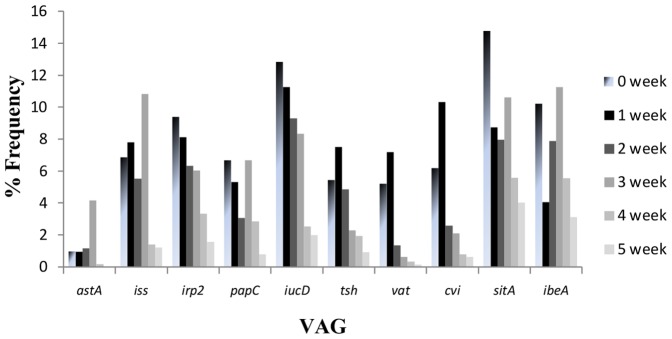
Average percentage frequency of VAGs.(inclusive of all flocks). Average percentage frequencies of 10 VAGs were calculated and plotted against time, from t = 0 (arrival) to t  =  week 5 (depopulation). Overall, VAGs appear to decline with time, with a peak in detection at week 3 for iss, sitA and ibeA. Iron acquisition genes irp2 and iucD consistently decline with time.